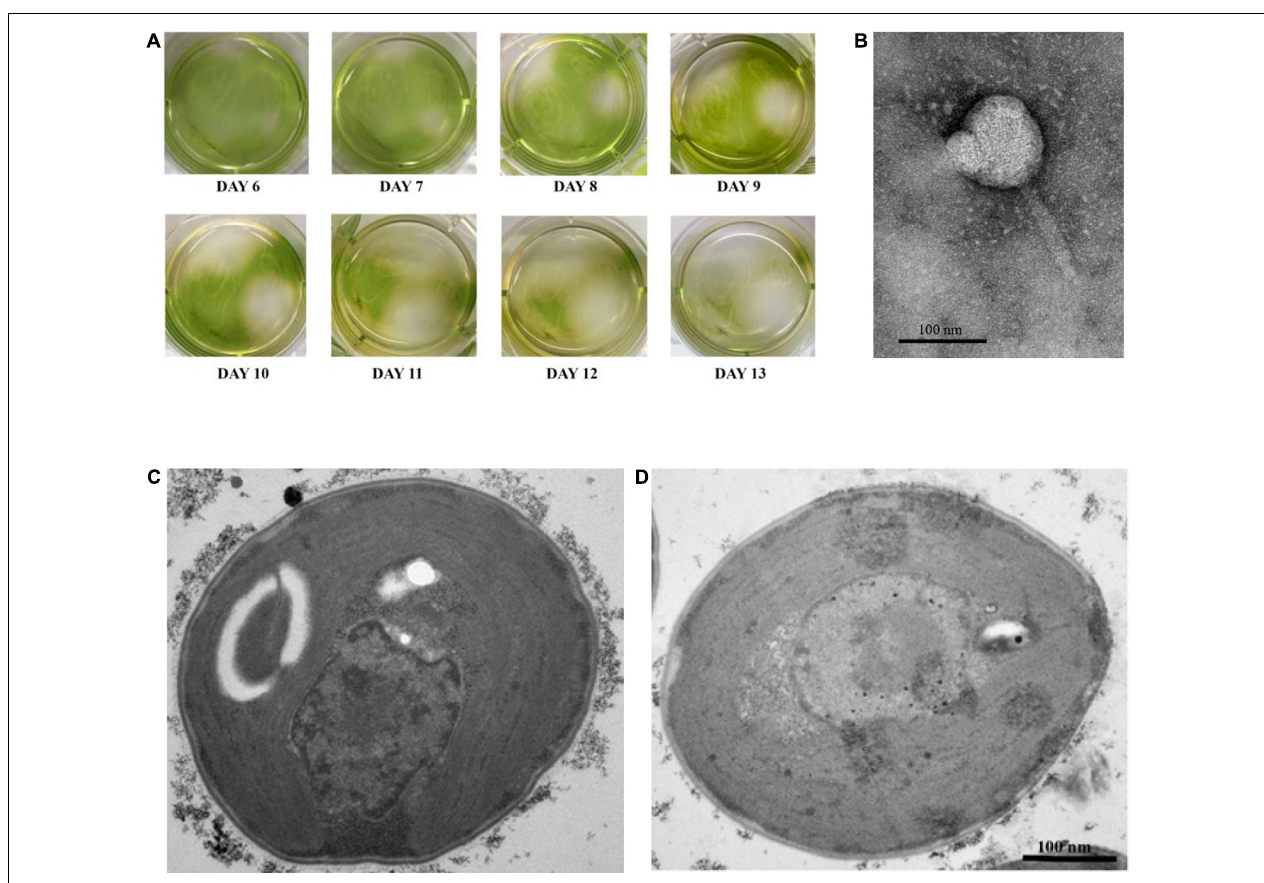
FIGURE 1 | (A) Plaques of cyanophage PhiMa05 on the lawn of SG03. TEM images of: (B) Cyanophage PhiMa05; (C) thin section of a healthy cell of Microsystis SG03; and (D) thin section of Microsystis SG03 2 days after incubation with